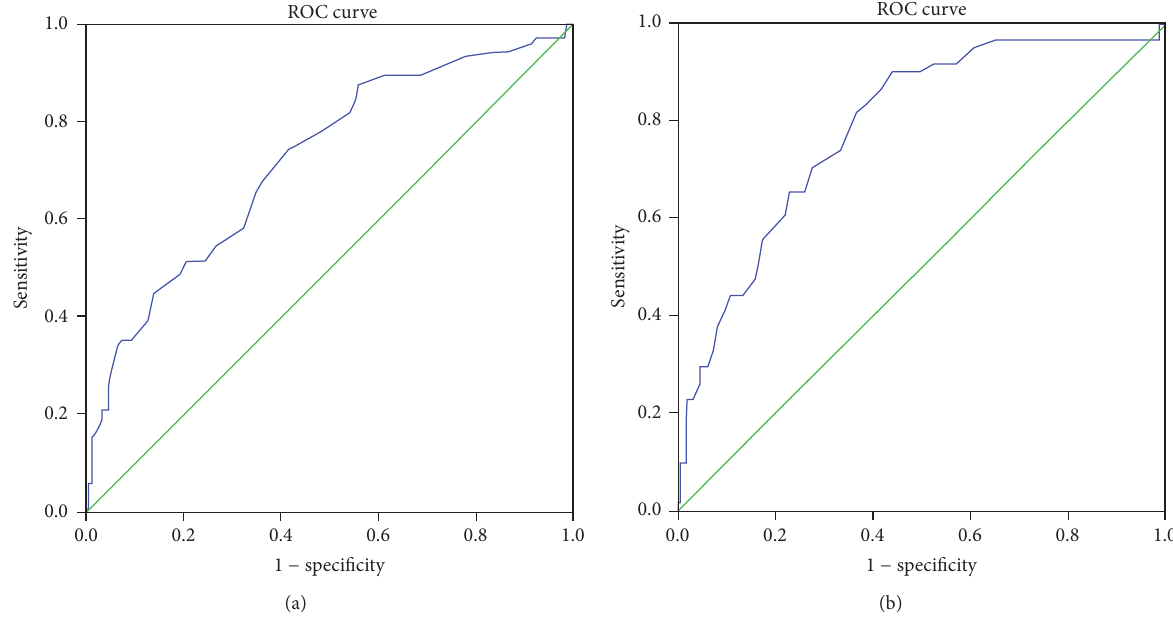
Figure 4: (a) Receiver Operating Characteristic (ROC) curve of uric acid with heart failure defined as ejection fraction < 50%. Area under the curve is 0.721, 𝑝 < 0.001 . (b) Receiver Operating Characteristic (ROC) curve of uric acid with heart failure defined as ejection fraction < 40%. Area under the curve is 0.788, 𝑝 < 0.001 .